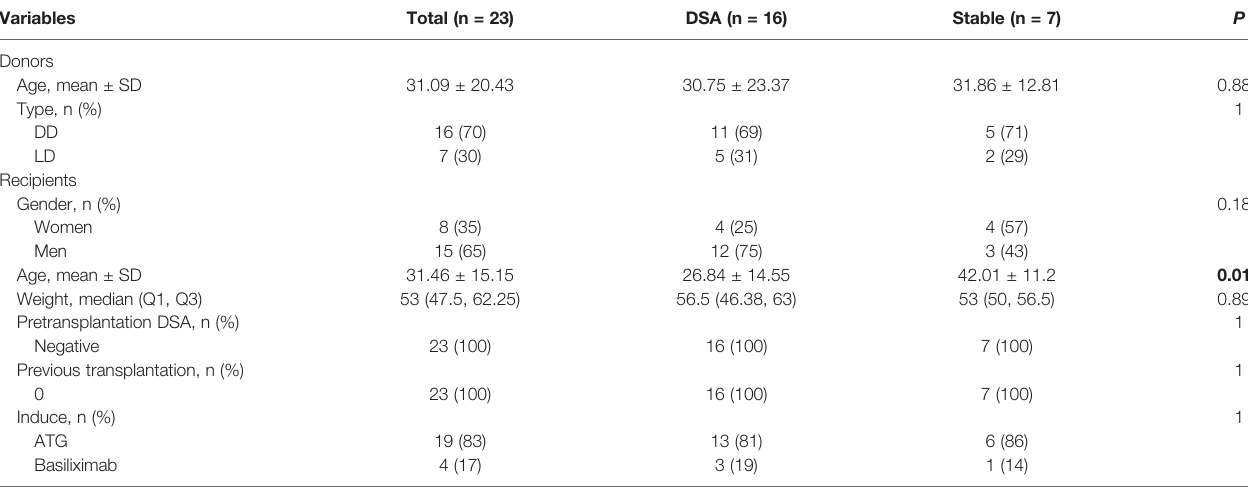
TABLE 2 | The demographics and clinical characteristics of DSA group and stable group in the nested case-control study. Variables Total (n = 23)